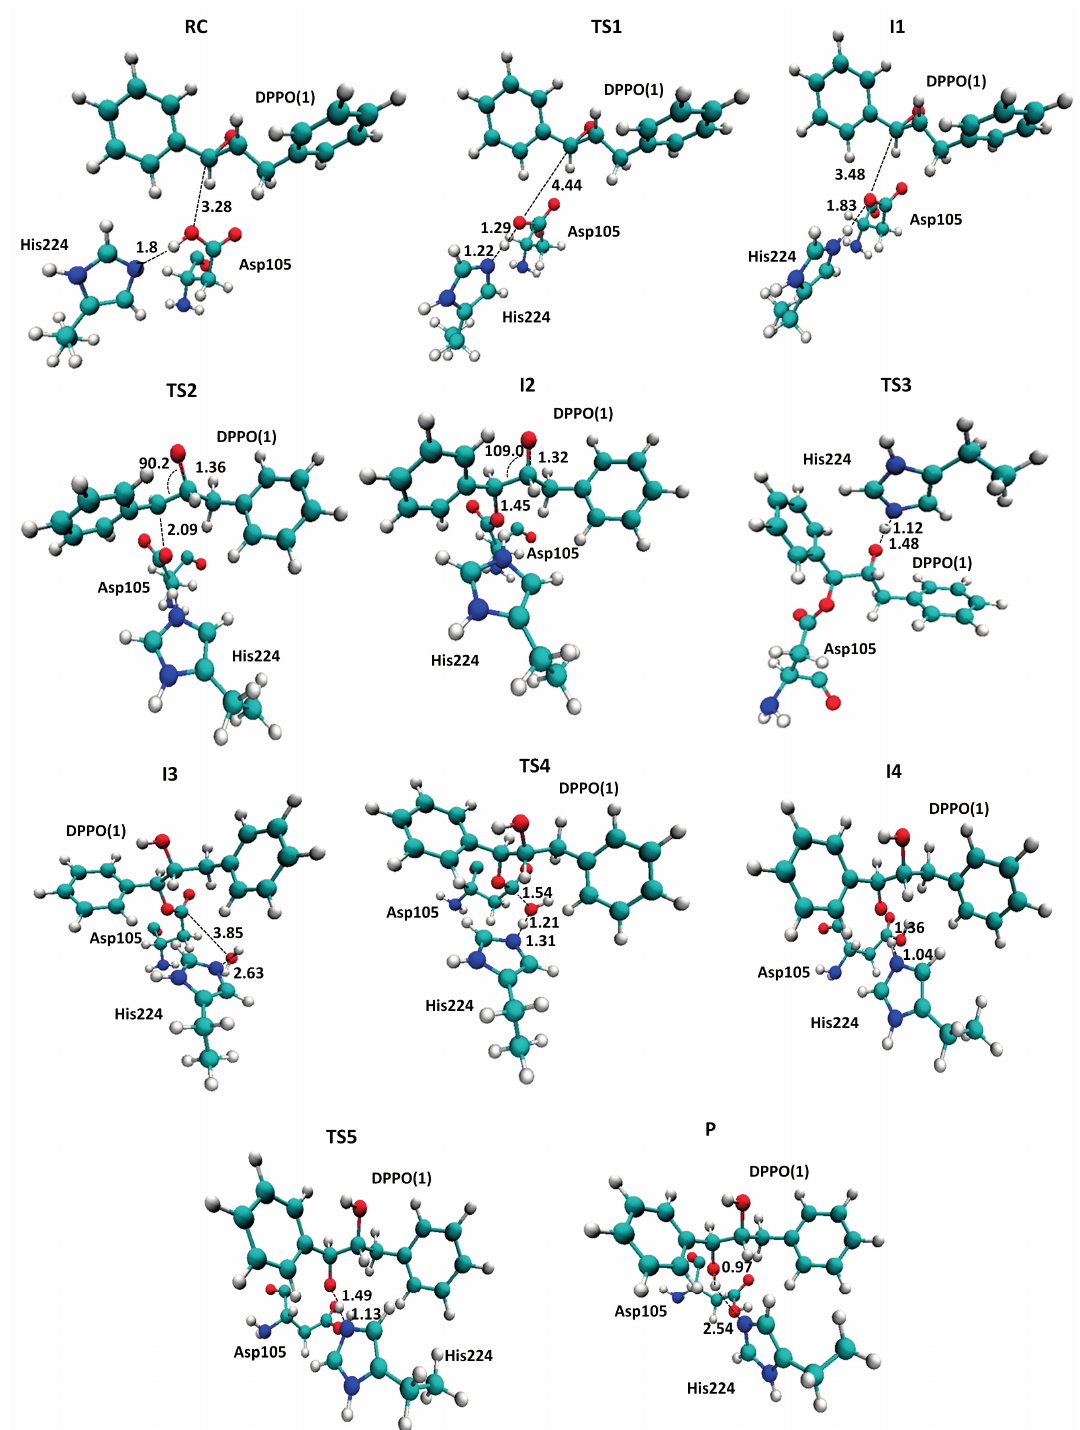
Figure 7. Localized structures for hydrolysis reaction of t-DPPO(1) catalyzed by Ser105Asp CALB. Key inter-atomic distances are reported in Å. Thr40 and Gln106, forming the oxyanion hole, are not displayed for the purposes of